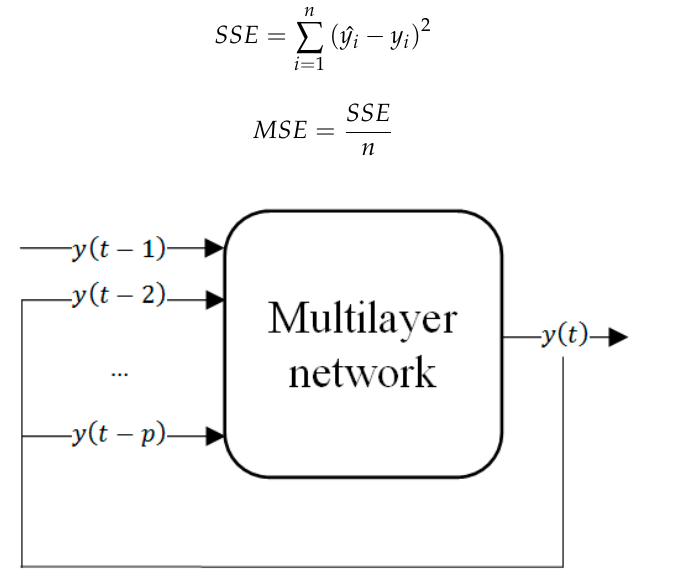
Figure 1. Non ‐ linear autoregressive (NAR) network. Figure 1. Non-linear autoregressive (NAR)